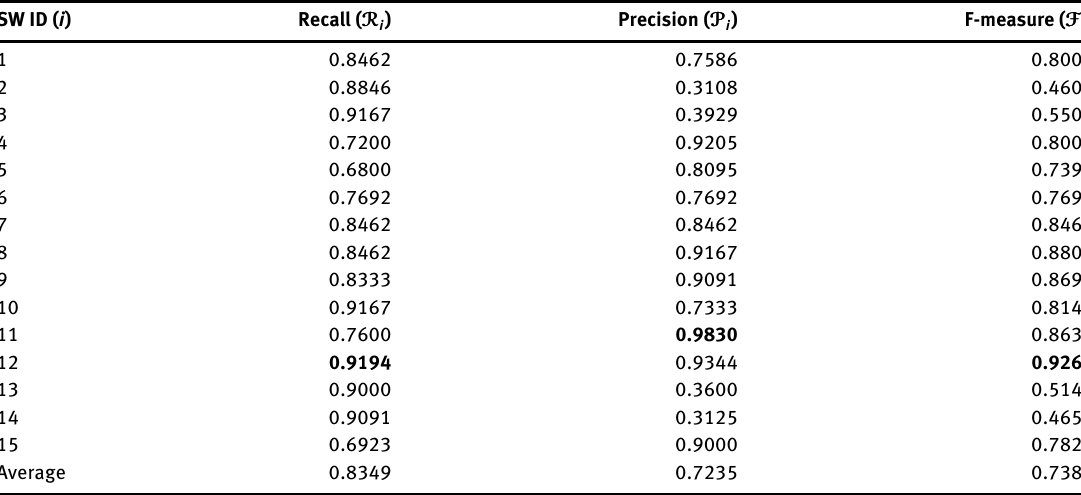
Table 4: Search Word-Wise Recall, Precision, and F-measure Values of Present Word Searching Technique.